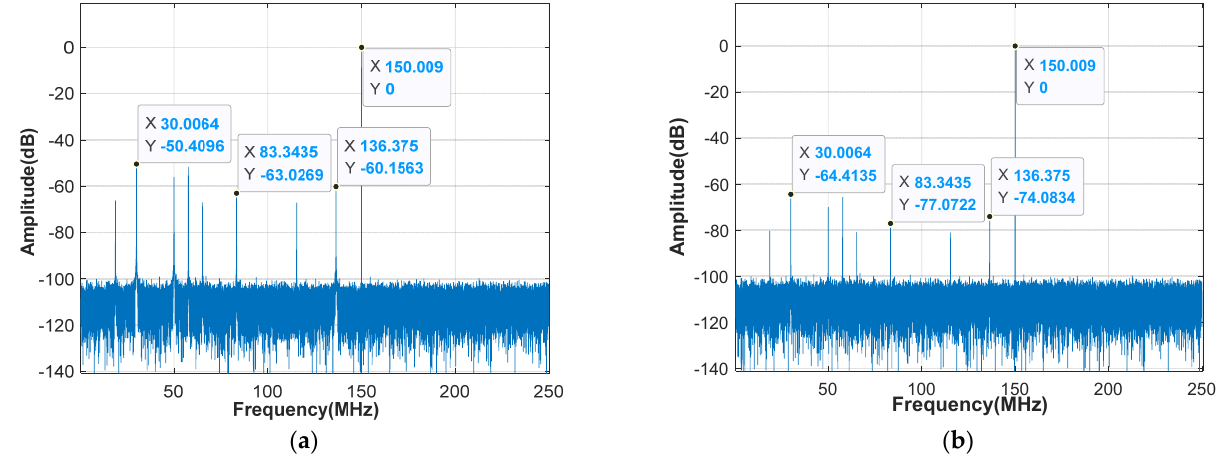
Figure 11. The output spectrum of the 150 MHz sinusoidal signal before and after compensation: ( a ) before calibration; ( b ) after calibration.